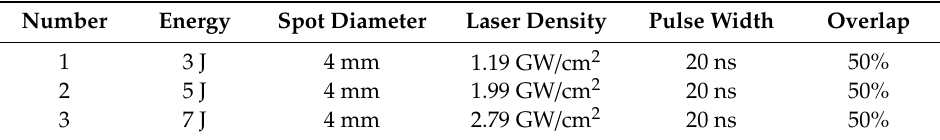
Table 2. Specific parameters of laser shock